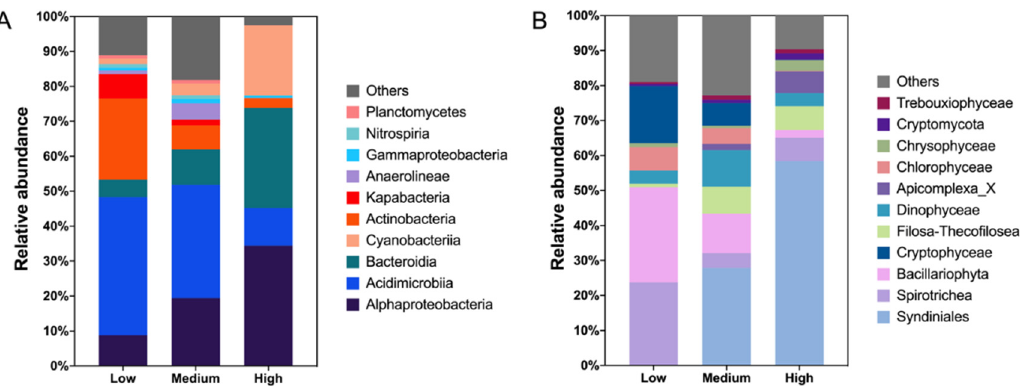
Figure 7. Average relative abundance of bacteria ( A ) and protists ( B ) at the class level in low-salinity cluster ( n = 7), medium-salinity cluster ( n = 5) and high-salinity cluster ( n = 15). Relative abundance of less than 1% was assigned to Others.